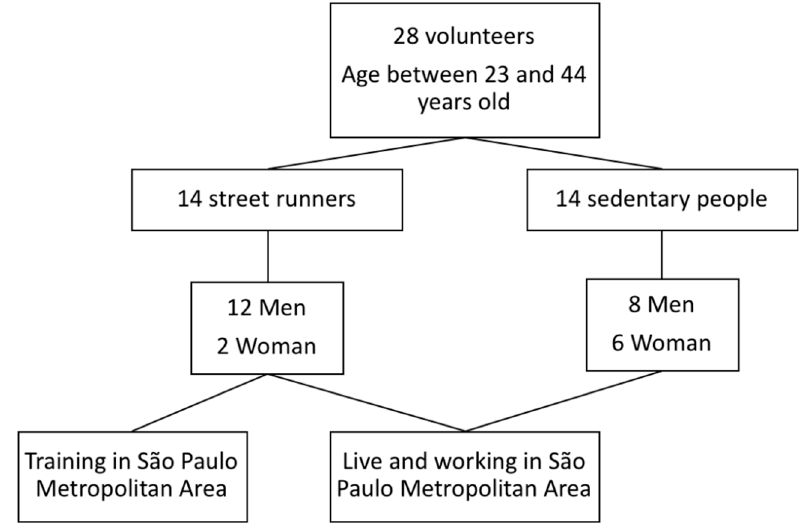
Figure 1. Flow diagram of the volunteer selections to participate in the study.